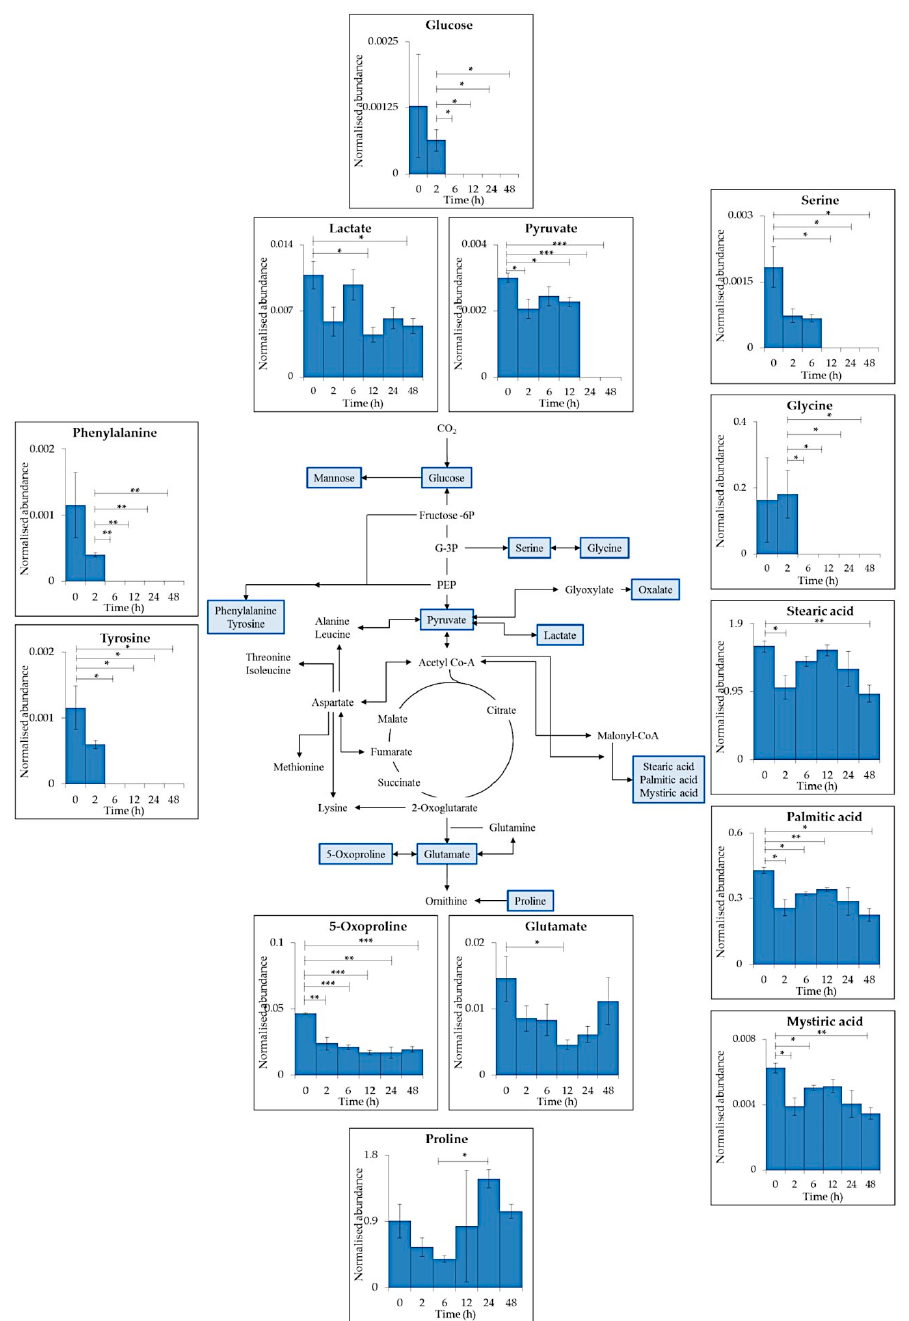
Figure 2. Schematic representation of a generalised reduced carbon metabolism in the cyanobacterium C. fritschii showing glycolysis, the citric acid (TCA) cycle, amino acid and fatty acid biosynthesis. Primary metabolites identified in intracellular samples using GC–MS are highlighted in blue with each insert presenting mean values of normalised abundance (normalised to internal standard and dry weight) ± standard error of each metabolite during supplemented UV-B exposure PAR + UV-B). Statistical significance between control (0 h) and UV-B exposure (2, 6, 12, 24 and 48 h) and between each treatment time point was measured using a two-sample T-test with equal variance; * = 0.05 ≥ p ≥ 0.01, ** = 0.01 ≥ p ≥ 0.001 and *** = p ≤